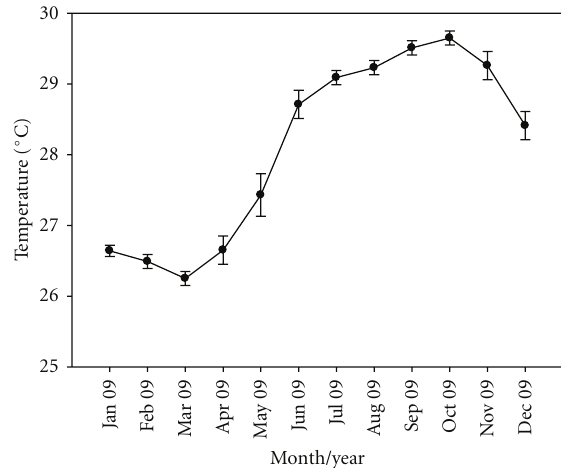
Figure 4: Line graph of monthly average ( ± SD) seawater tempera- tures from January–December 2009 in La Parguera, Puerto